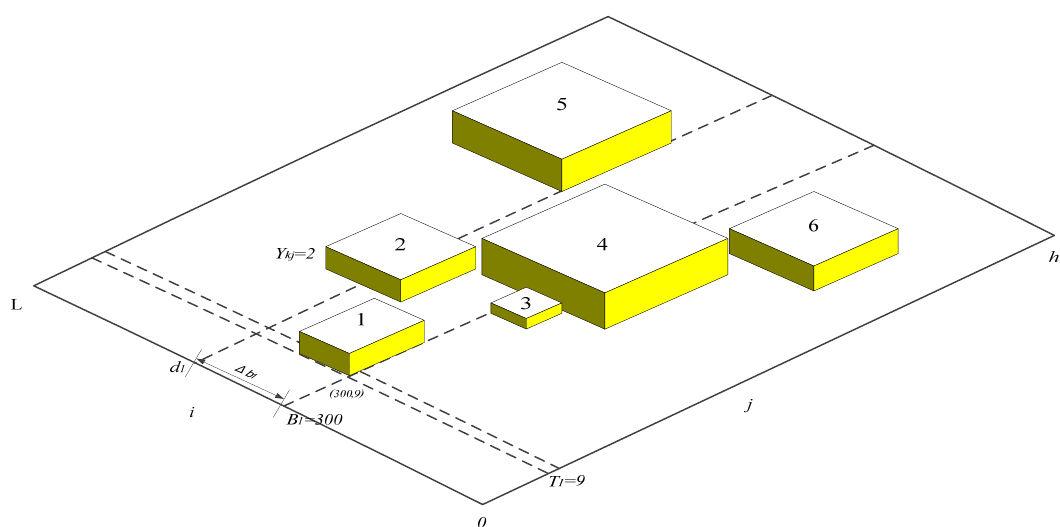
Figure 4. A three-dimensional (3D) berthing plan.